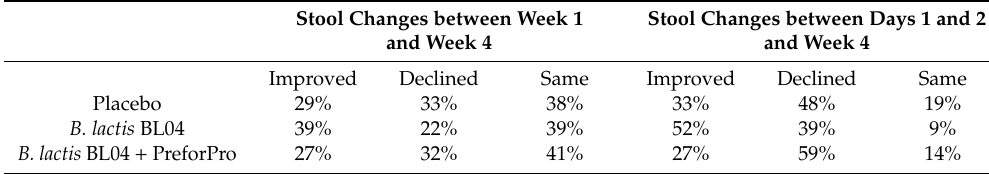
Table 6. Stool consistency changes from baseline to follow-up visit.